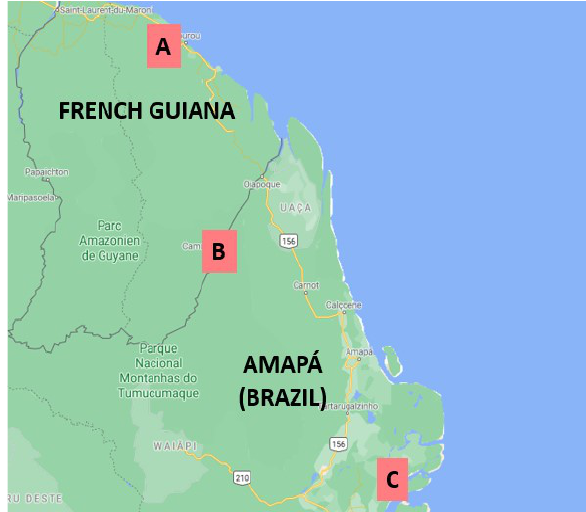
Figure 1. Location of study areas in French Guiana and Amapá